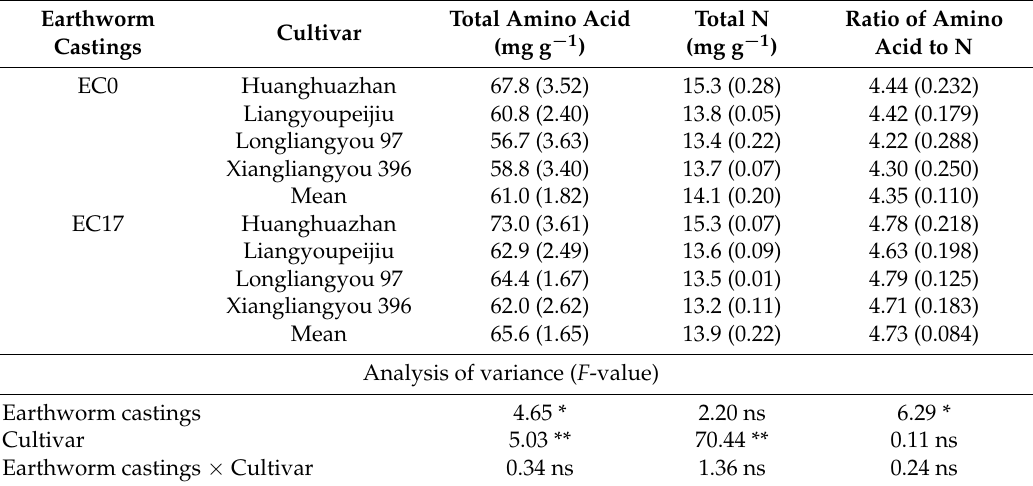
Table 1. Effects of earthworm casting application on total amino acid and nitrogen (N) content and on ratio of amino acid to N in grains of four rice cultivars.